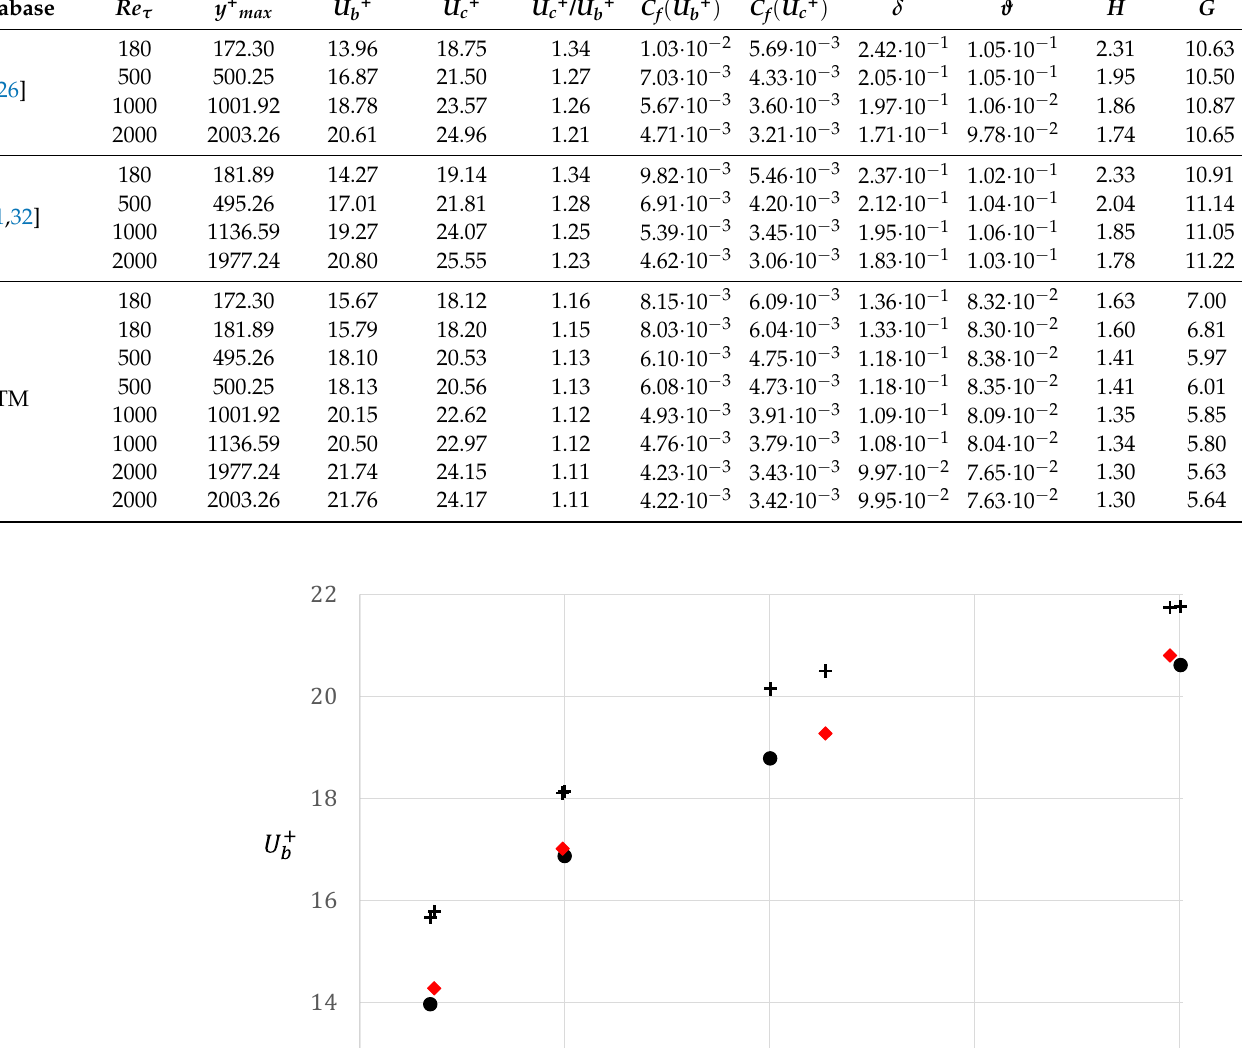
(cid:0) (cid:1) U b + (cid:0) (cid:0) (cid:1) = (cid:1) U b + U c + 2/ U b + 2 ; C f the skin friction based (cid:0) (cid:1) = U c + 2/ U c + 2 ; δ the displacement thickness, which for pipe is (cid:16) (cid:17) (cid:82) 1 ( 1 − ζ ) d ζ , where ζ = y + / y + max ; ϑ the momentum thickness 1 − u + U c + 0